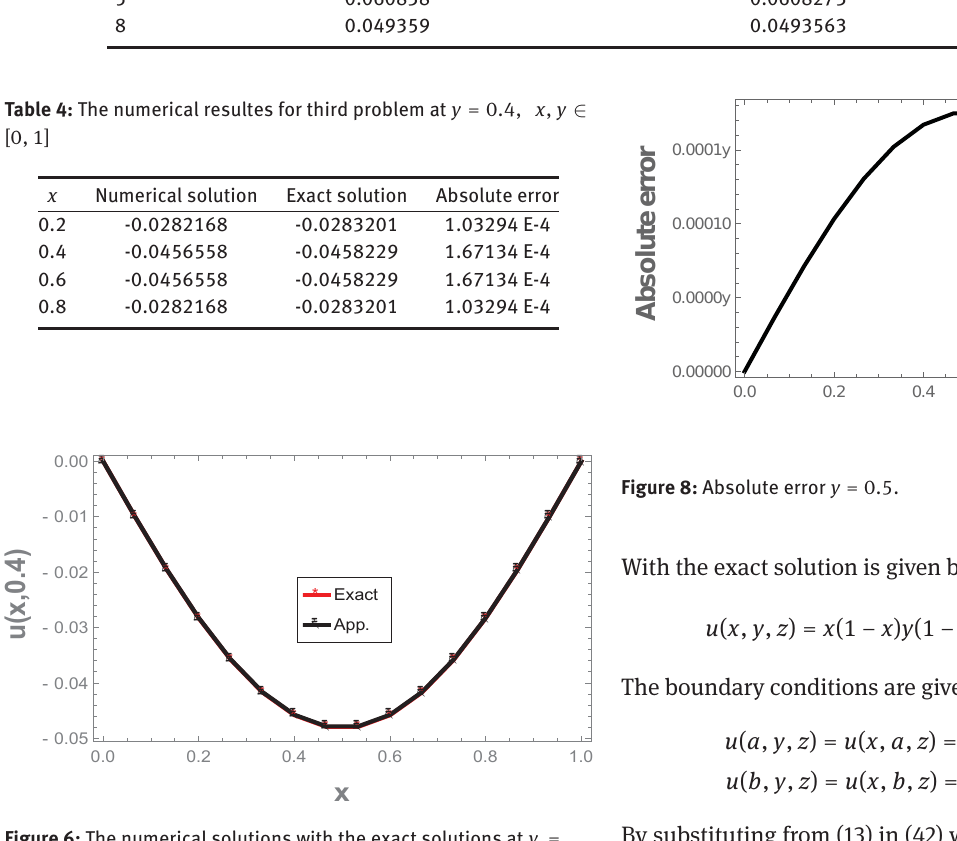
Figure 6: The numerical solutions with the exact solutions at y =